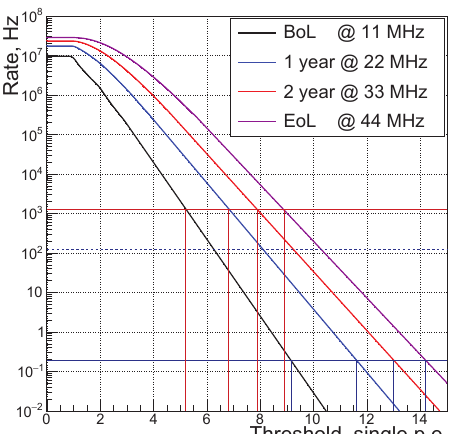
Figure 15: Single pixel trigger rate as a function of the threshold expressed in p.e. for DCR + NGB values es- timated at di ff erent times during the mission life. The horizontal blue dashed line corresponds to the maximum trigger rate of (120 Hz). Horizontal blue line corresponds to the maximum single pixel trigger rate (120 Hz / 640 ∼ 0.18 Hz per pixel). The horizontal red line corresponds to 1250 Hz (maximum single pixel rate for configuration with two pixels cluster). The vertical lines shows thresh- olds for single (blue) and double coincidence (red) trigger logic. Thresholds can be reconfigured during